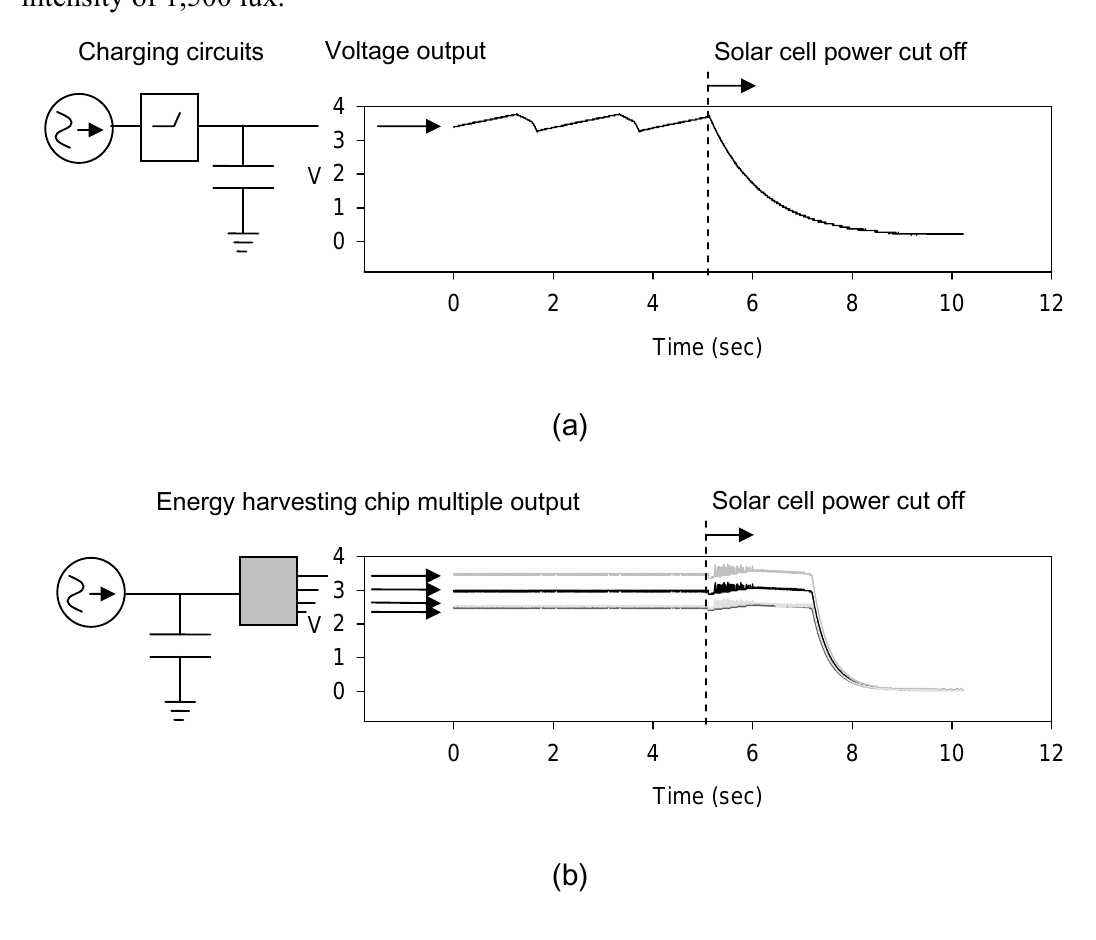
Figure 4. Voltage outputs from the traditional switching circuits used for solar cell charging (a), and the multiple outputs from the energy harvesting chip (b). The test condition is under the constant artificial light illuminating on the solar cell with the intensity of 1,500